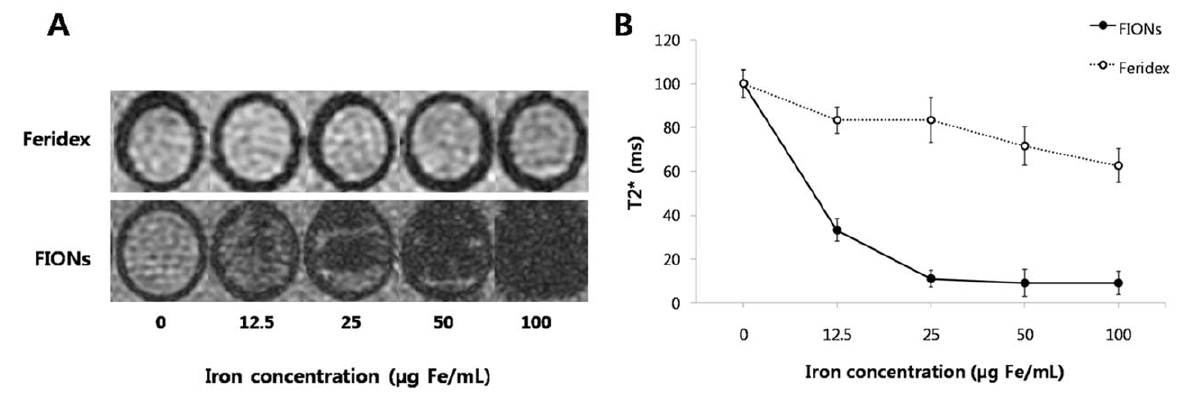
Figure 4. Invitro T2* measurement of macrophages labeled with iron oxide. (A) MR phantom of the labeled macrophages was constructed in 1% agar/PBS. T2* MR images showed that the SI significantly decreased when the macrophages were labeled with FIONs. However, the SI of Feridex labeled macrophages was poorly differentiated. (B) The T2* of the macrophages was found to decrease from 100 6 6.40 ms in the absence of FIONs. The T2* of the FION-labeled macrophages was decreased when the incubation concentration reached 50 m g Fe/mL (9.09 6 6.02 ms), however, the T2* of the macrophages labeled with 100 ( m g Fe/mL) Feridex (62.50 6 7.69 ms) was higher than that of the macrophages labeled 12.5 m g Fe/mL FIONs (33.33 6 6.02 ms).